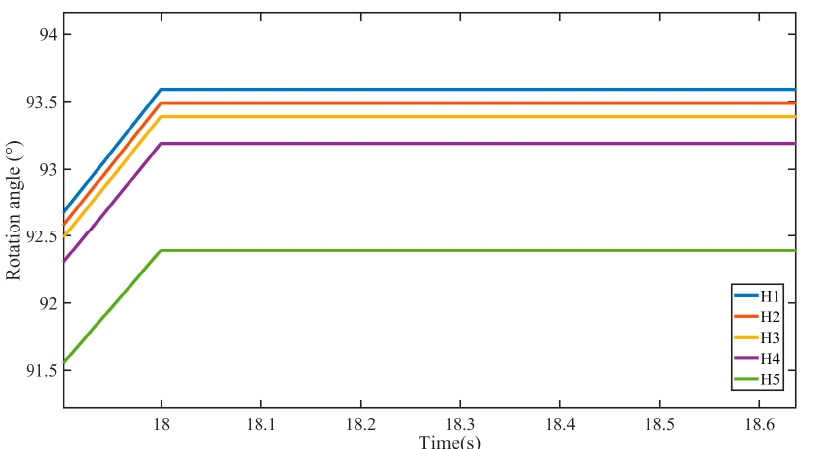
Figure 14. The r otation angle of leakage in reversing valve. Figure 14. The rotation angle of leakage in reversing valve.